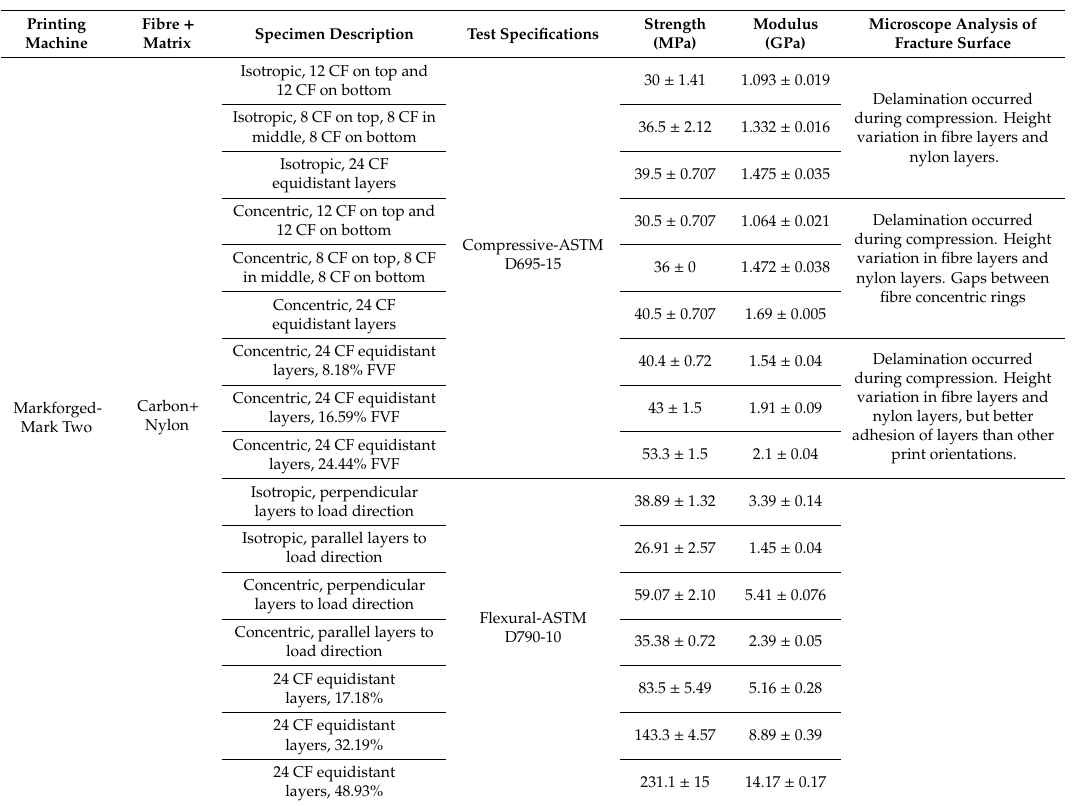
Table 2. Infill pattern, fibre volume fraction (FVF), compressive strength and microstructural analysis details